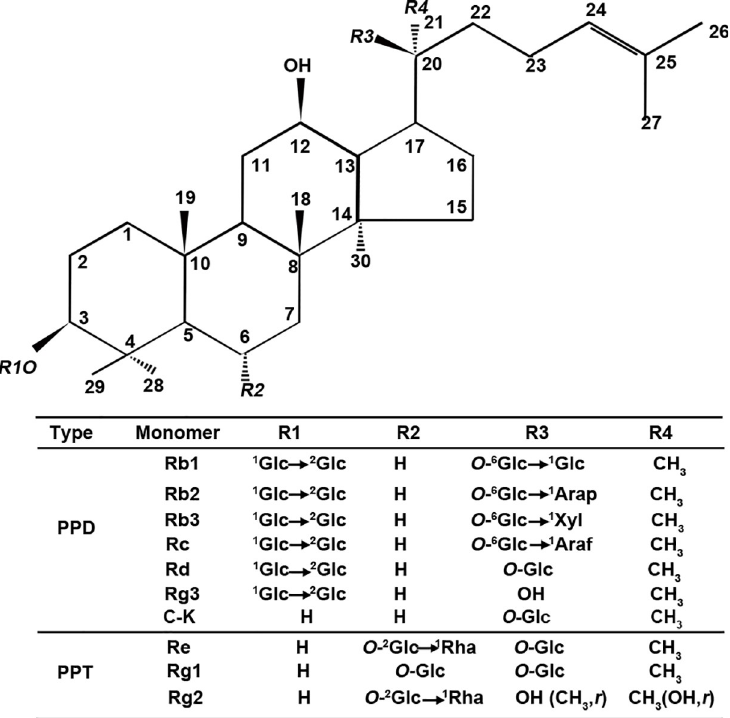
Fig 1. The chemical structure of PPD and PPT type saponins. Glc, β -D-glucopyranosyl; Rha, α -L-rhamnopyranosyl; Ara(f), Arabinose (furanose form); Ara(p), arabinose (pyranose form).